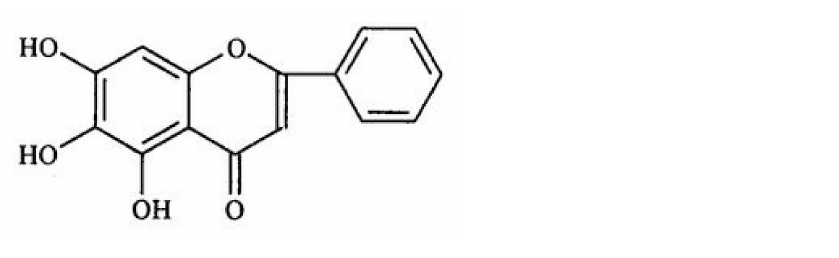
Figure 1. Molecular structure of baicalein. The IUPAC name of baicalein is 5,6,7-Trihydroxy-2- phenylchromen-4-one, or also known as 5,6,7-trihydroxyflavone.